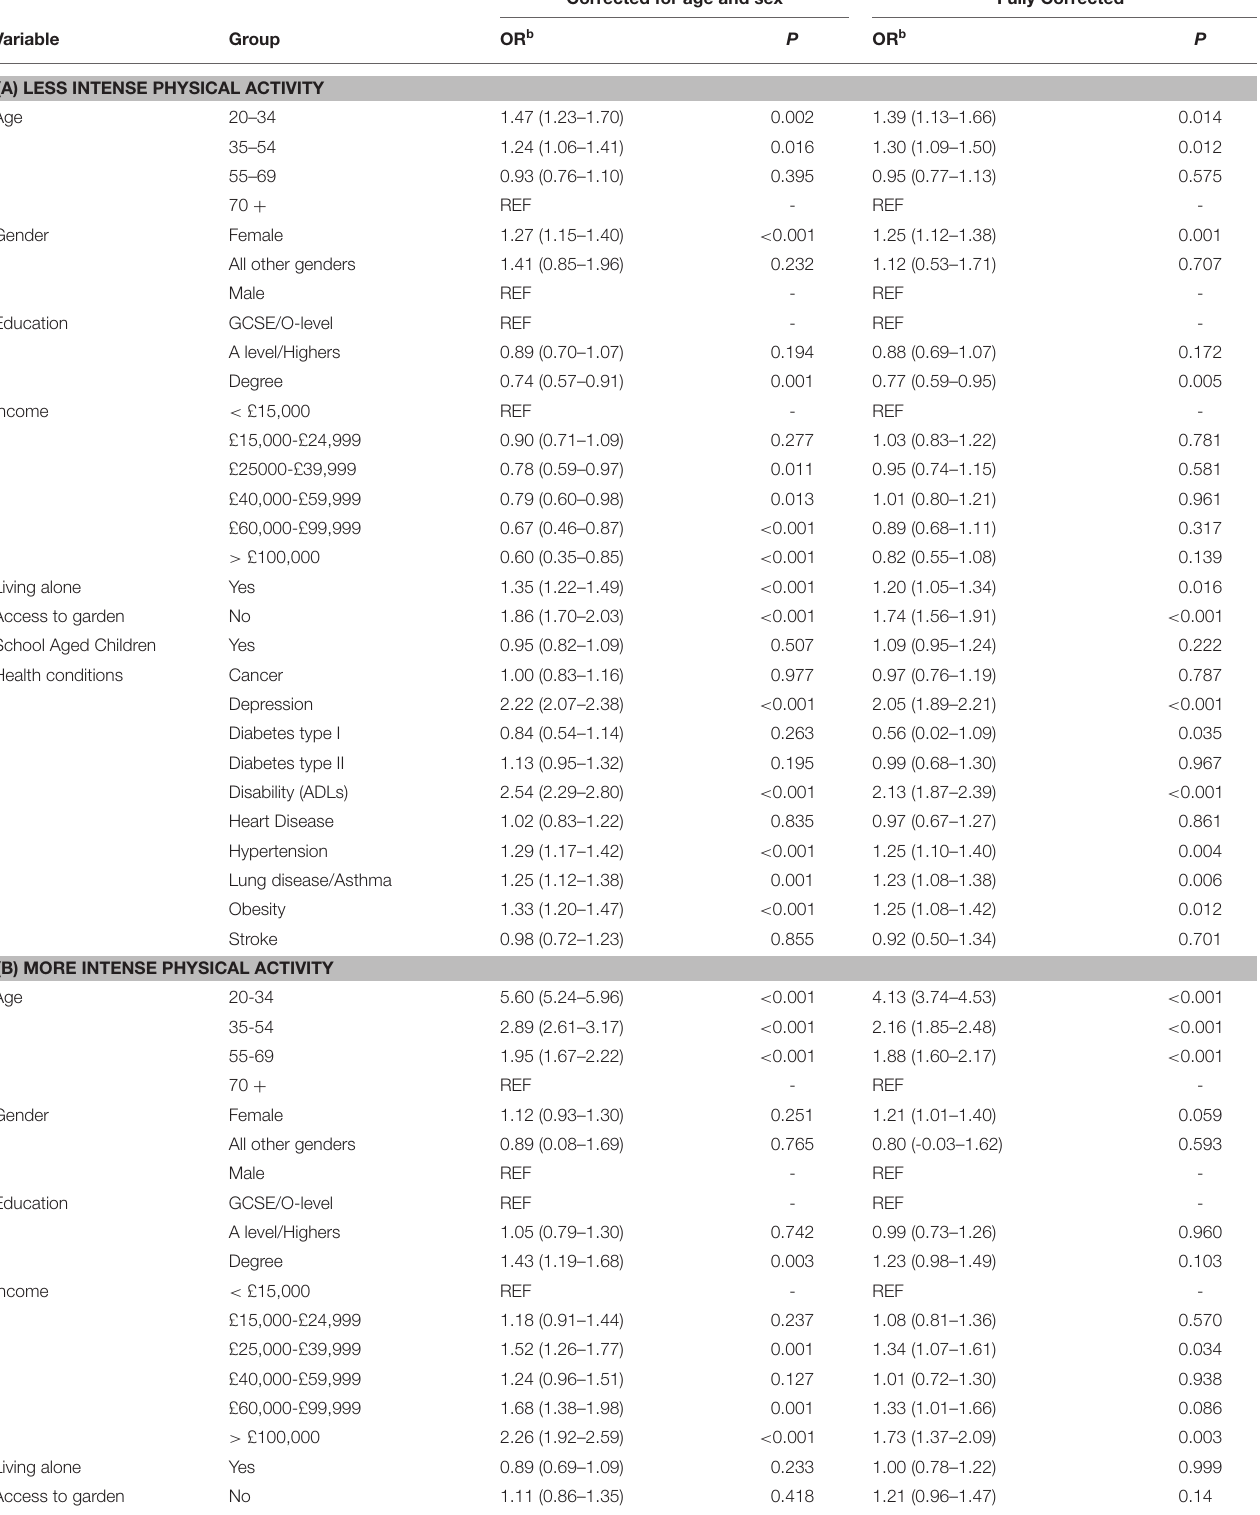
TABLE 2 | Odds ratios for change in intensity of physical activity toward (a) less intense and (b) more intense physical activity since the UK COVID-19 lockdown began. Corrected for age and sex Fully Corrected